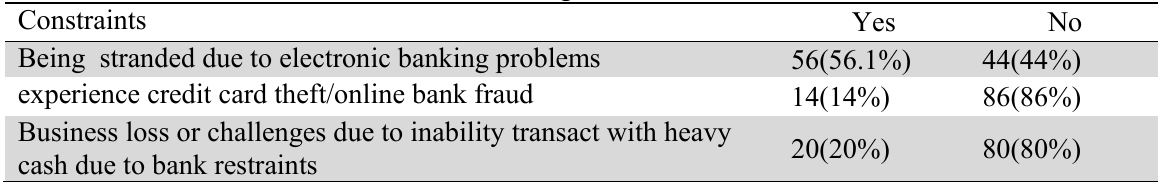
Constraints to the utilization of electronic banking